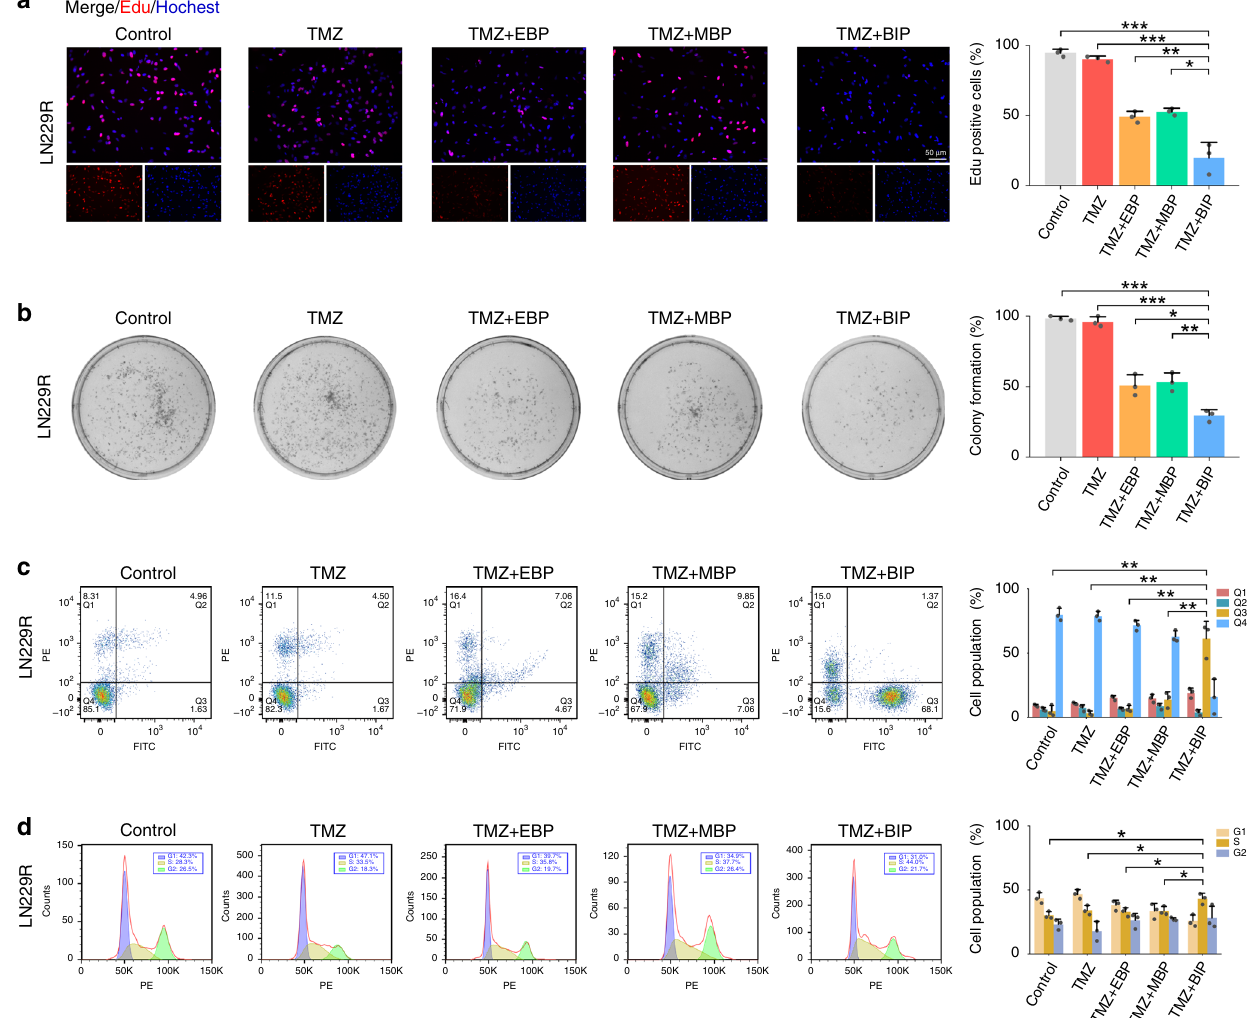
Fig. 4 The TMZ sensitivity enhanced by BIP-MPC-NP in LN229R cells. a , b The EdU assay and colony formation assay of LN229R with treatments of TMZ and different nanoinhibitors. The histogram displayed the statistics of EdU assay and colony formation assay, respectively ( n = 3). Scale bar = 50 μ m. c , d The cell apoptosis assay and the cell-cycle analysis were performed with fl ow cytometry in LN229R. The histogram displayed the statistics of apoptosis assay and the cell-cycle analysis, respectively ( n = 3). The error bars represent the S.D. of three measurements. P value was determined by Student ’ s t